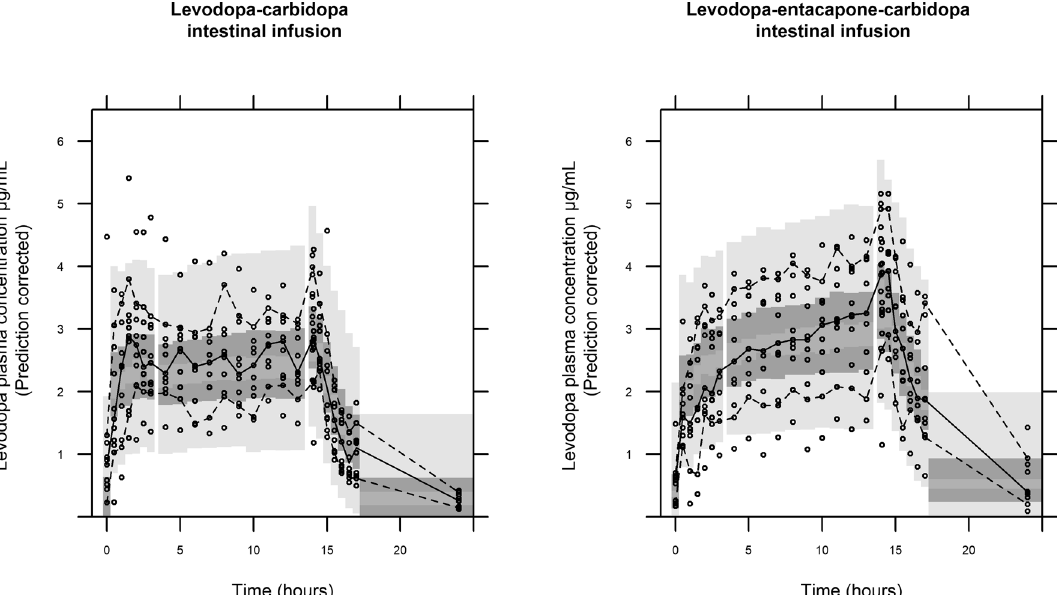
Figure 1. Prediction corrected visual predictive check (1000 samples) of the concentration–time data for LCIG and LECIG. The solid line is the median of the observed data. The dashed lines represent the observed 10th and 90th percentiles of the observations. The top and bottom light grey areas are the 95% confidence intervals for 10th and 90th percentiles of the simulated data. The middle dark grey area is the 95% confidence interval for the median of the simulated